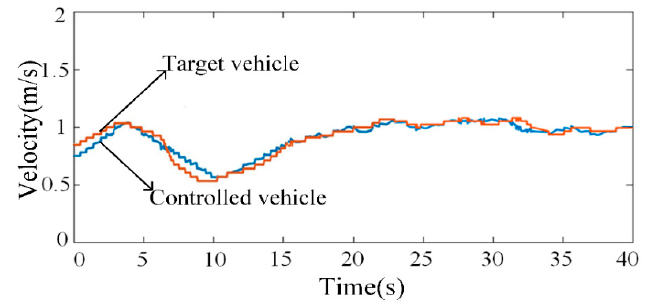
Figure 12. Convergence diagram of velocity from variable velocity to constant velocity.